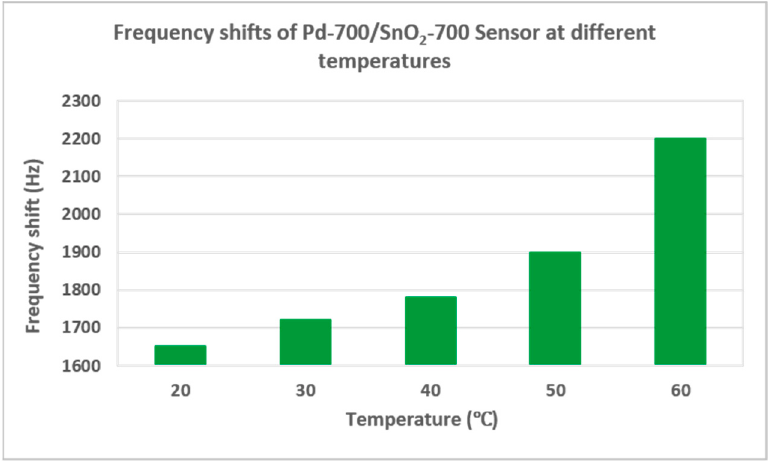
Figure 8. Frequency shifts of Pd-700/SnO 2 -700 sensor, at different temperatures, for a concentration of 0.8% hydrogen.